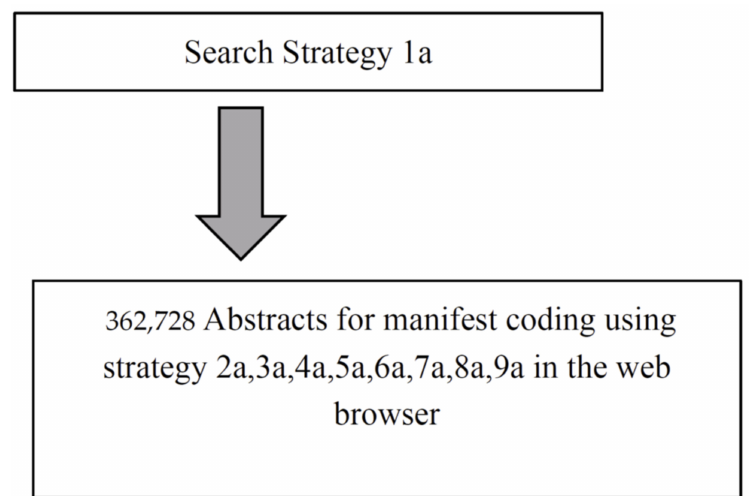
Figure 1. Search strategy for obtaining abstracts for manifest coding for the technical quantum terms in the databases.